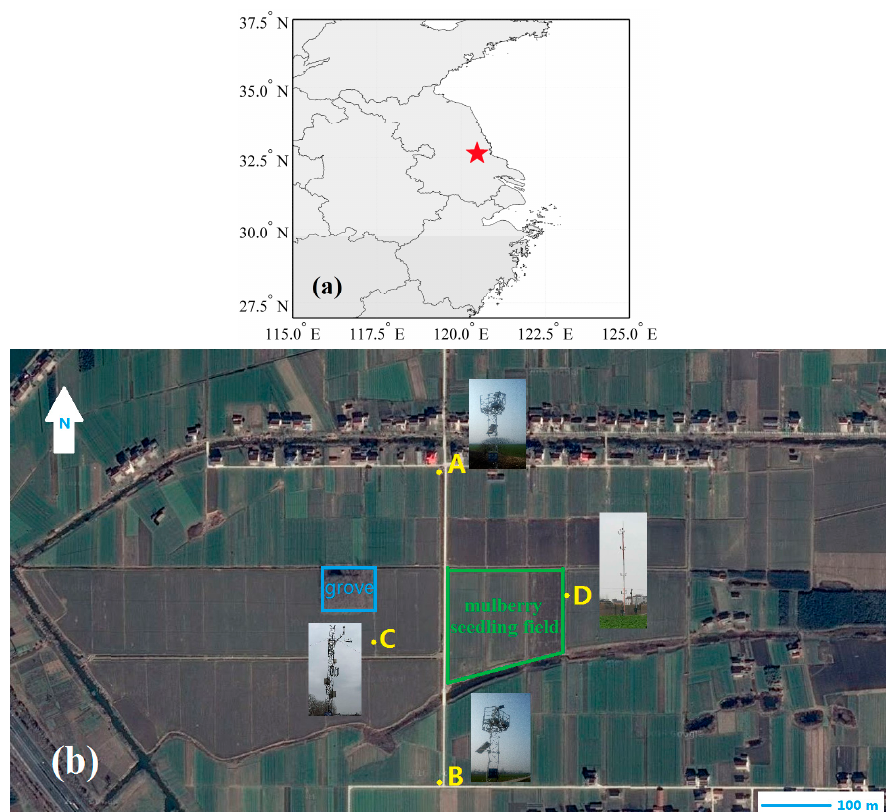
Figure 1. ( a ) Map of eastern China; the location of the experimental site is shown as a red star; ( b ) The experimental site. Points A and B are the transmitter and receiver of the large aperture scintillometer (LAS) with an optical path of 470 m, respectively; C is the eddy covariance (EC) system; and D is the automatic meteorological station (AWS). The mulberry seedling field and grove field are also shown with green and blue frames, respectively. Concrete roads are shown as white bands.